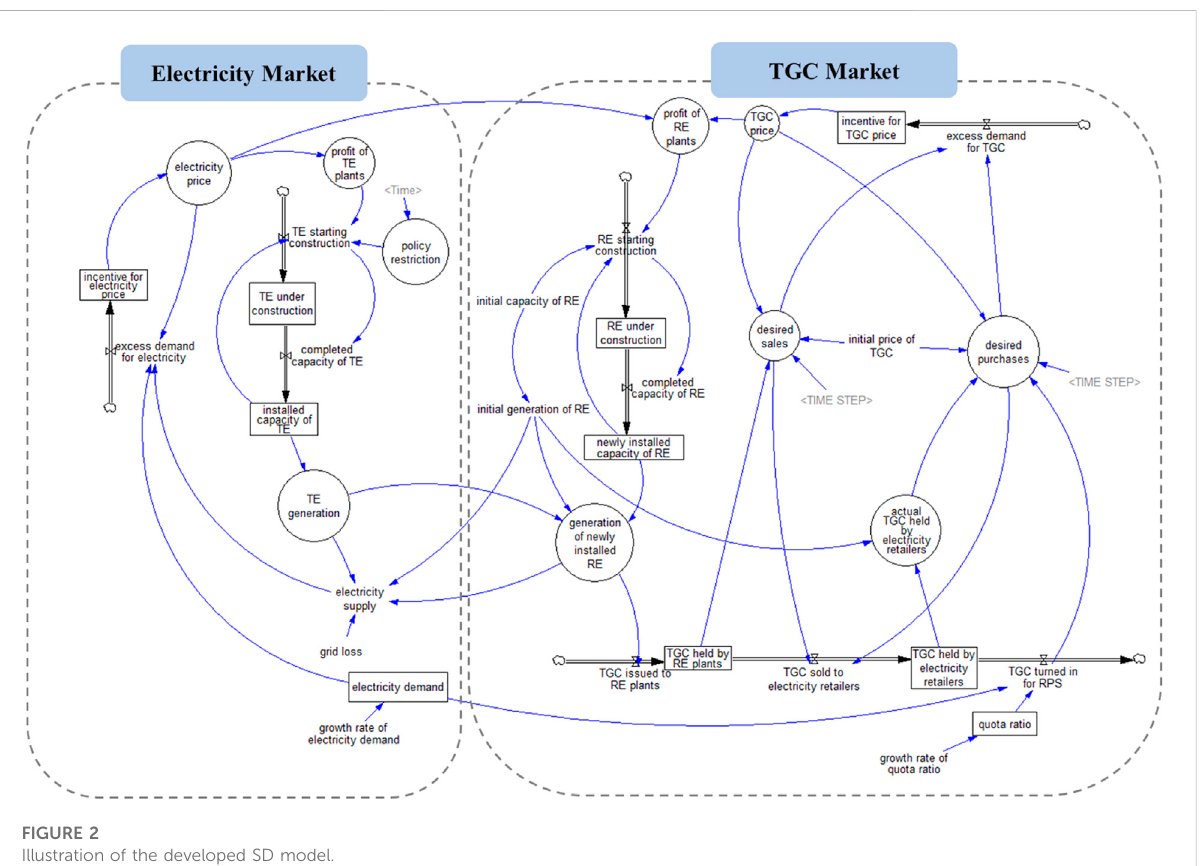
FIGURE 2 Illustration of the developed SD model.